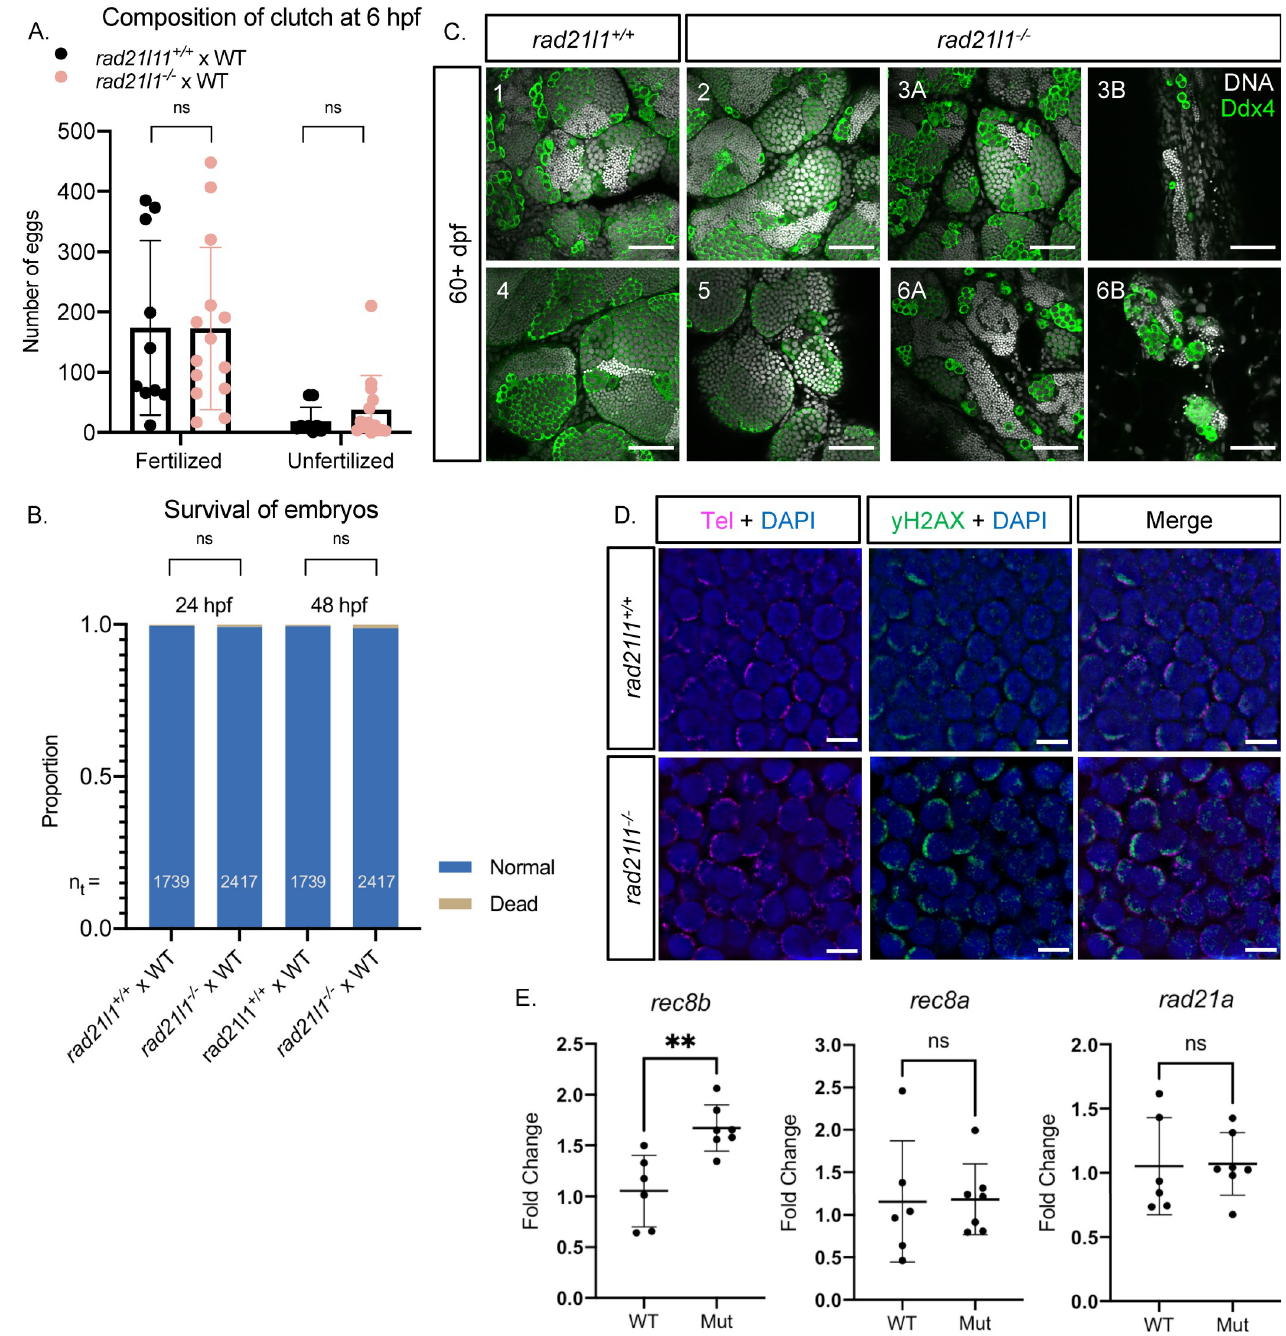
Fig 3. Rad21l1 is dispensable for male fertility. (A/B) Data resulting from test crosses between rad21l1 -/- males and wild-type females to assess fertility and reproductive phenotype. rad21l1 +/+ male tank mates were used as controls. No significant difference in the number of eggs the males caused the females to release, the composition of the resulting clutch at 6 hpf, or the survival of the embryos through 48 hpf. Data pooled from 14 crosses over 5 weeks using the same pool of 14 rad21l1 -/- males, 12/14 of which crossed successfully at least once. Unpaired, two-tailed student t-test used for statistical analysis, ns = p > 0.05. (C) Whole mount adult testes stained for DNA (gray) and Ddx4 (green) showing a phenotypic range of gonad morphology in rad21l1 -/- males. All samples except #5 displayed large clusters of mature sperm. Images marked as A and B were taken from the same sample to show variation within a single gonad. Wild-type tank mates used as controls. Scale bar = 50 μ m. (D) Testes sections stained with a PNA telomere probe (Tel; magenta), an antibody to γ H2AX (green), and DAPI (blue), showing that telomere clustering and DSB localization ( γ H2AX) are normal in the rad21l1 mutant. Scale bar = 5 μ m. (E) Fold change of relative mRNA expression for rad21l1 paralogs, r ec8b , rec8a , and rad21a in wild-type versus the rad21l1 -/- mutant (Mut). Fold change was determined using the 2 - ΔΔ Cq method. eF1a (housekeeping) mRNA levels were used as a